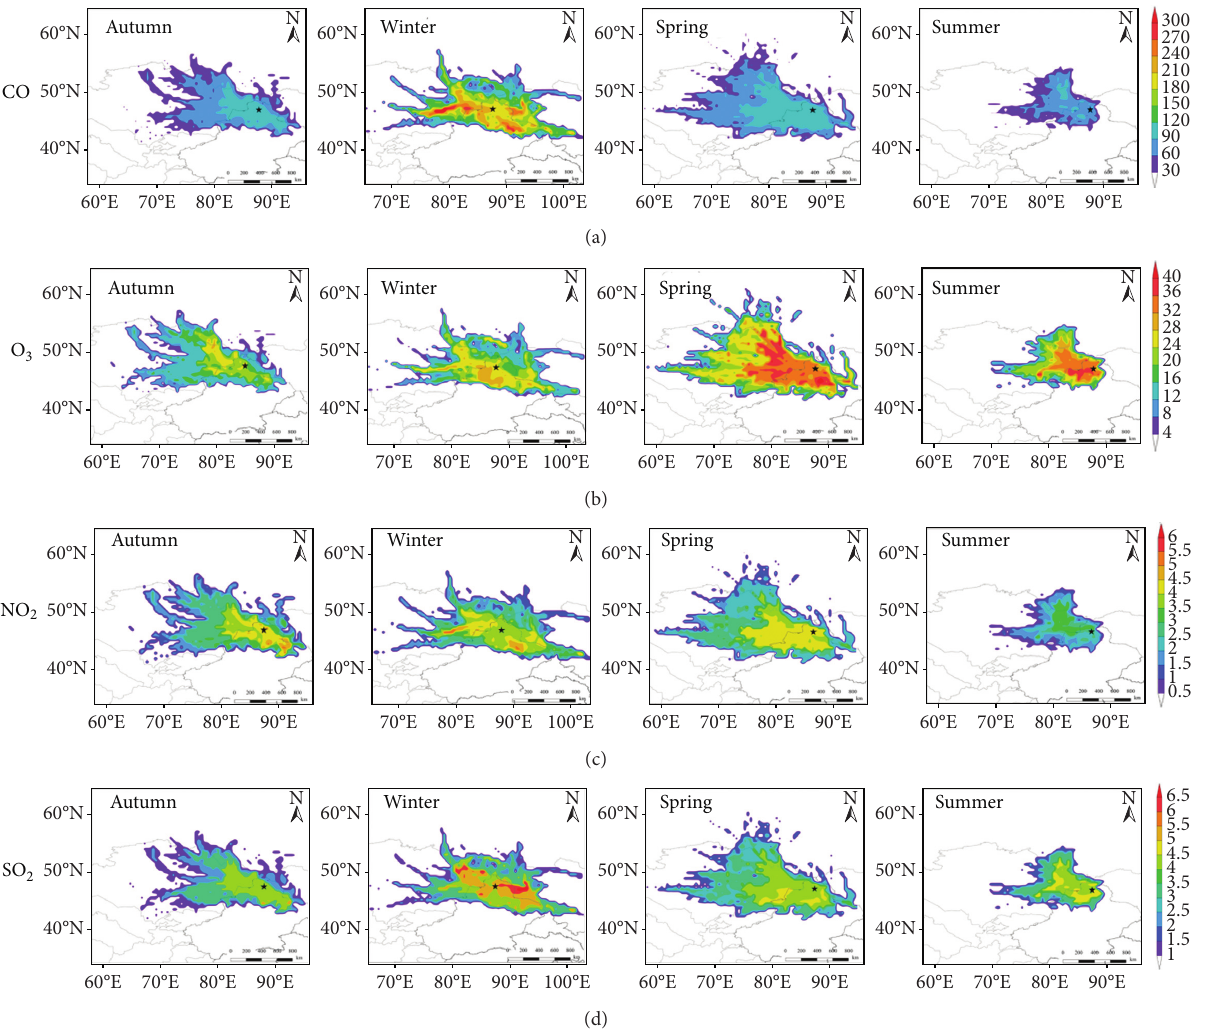
Figure 9: Seasonal distribution of the weighted concentration-weighted trajectory (WCWT) in Akedala, from September 1, 2017, to August 31, 2018. The black star represents Akedala